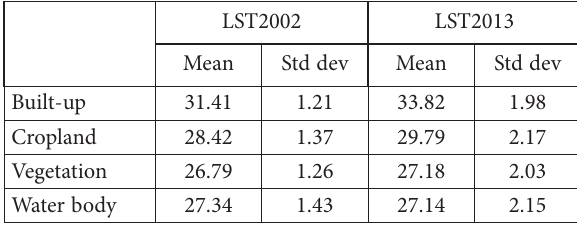
Table 6. Average LST associated with land cover types (unit: °C)